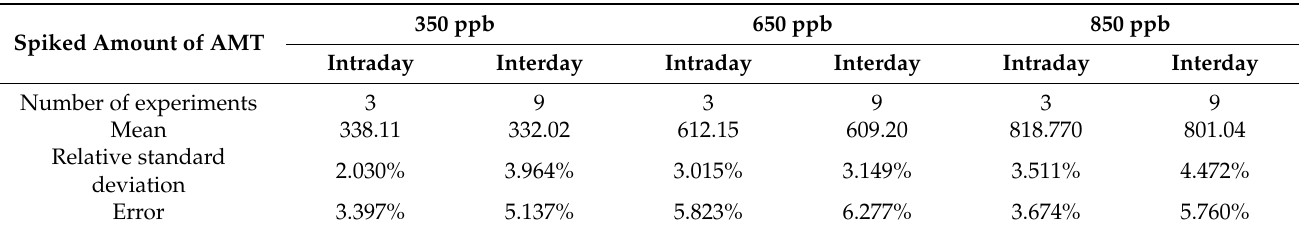
Table 2. Precision and accuracy of controls in dried blood samples.